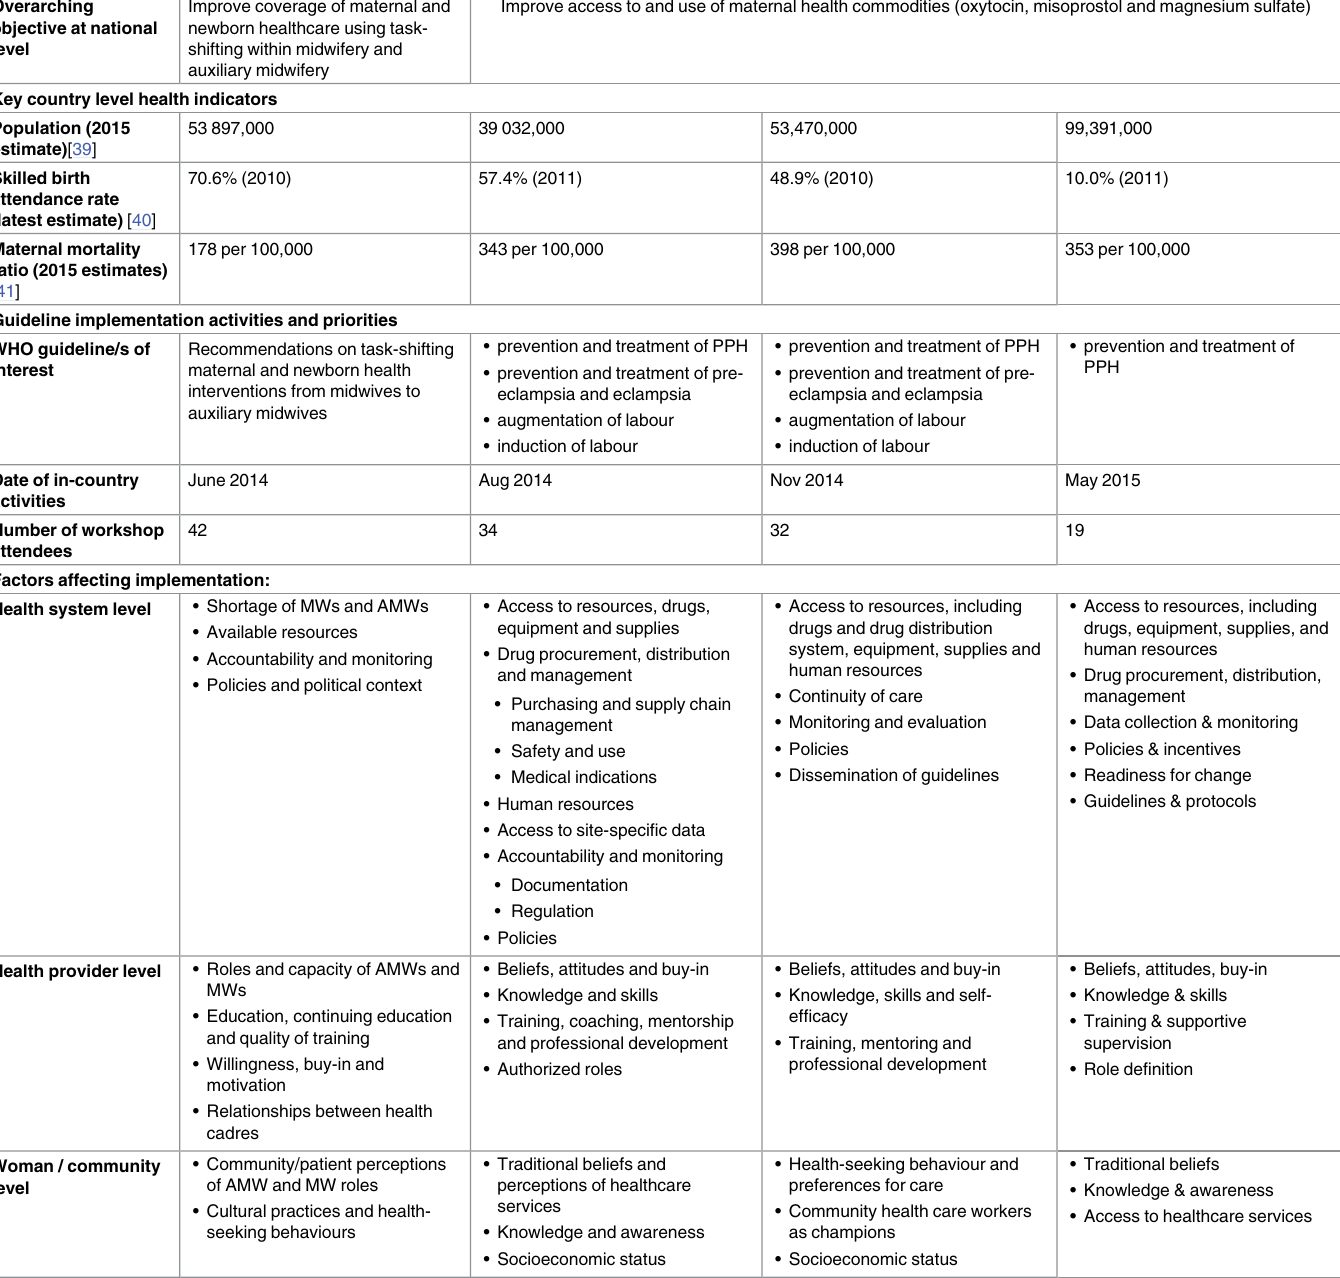
Table 1. Summary of indicators and guideline implementation researchactivities and outcomes in four